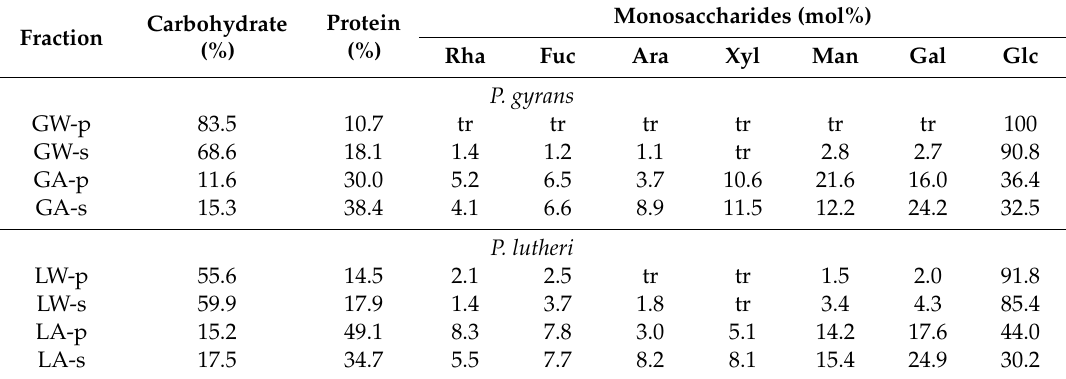
Table 1. Chemical analyses and monosaccharide composition of fractions from P. gyrans and P. lutheri .